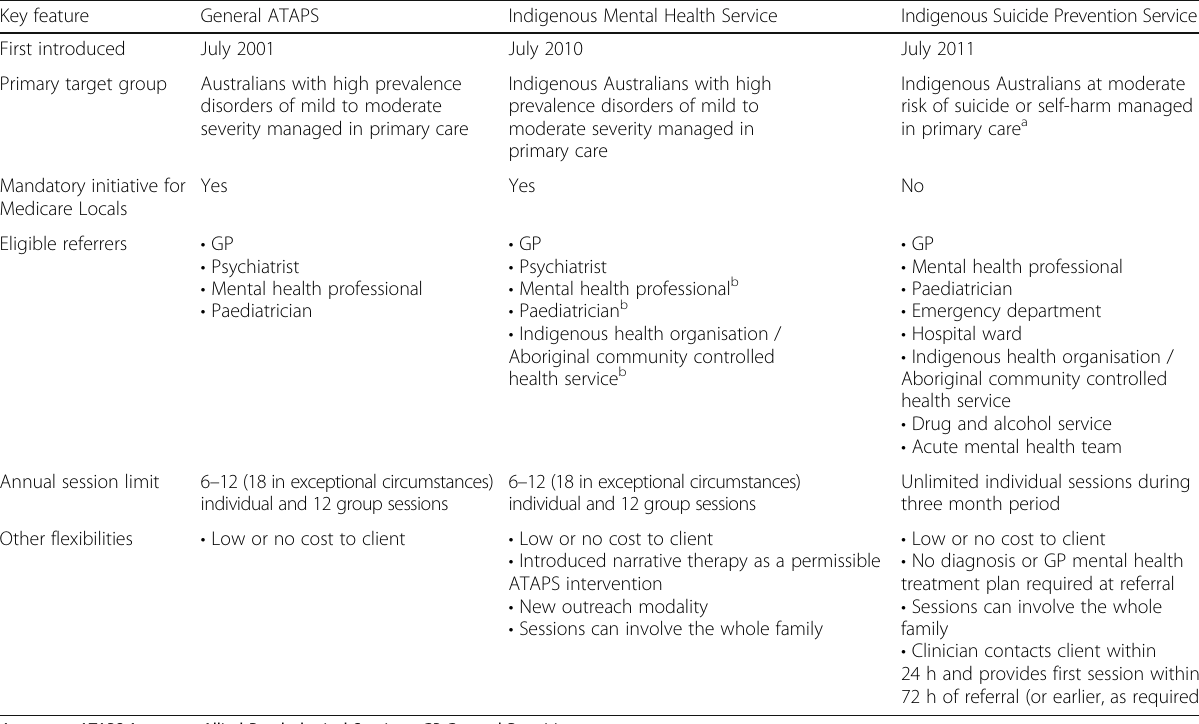
Table 1 Key features of enhanced Indigenous ATAPS services and the general ATAPS initiative Key